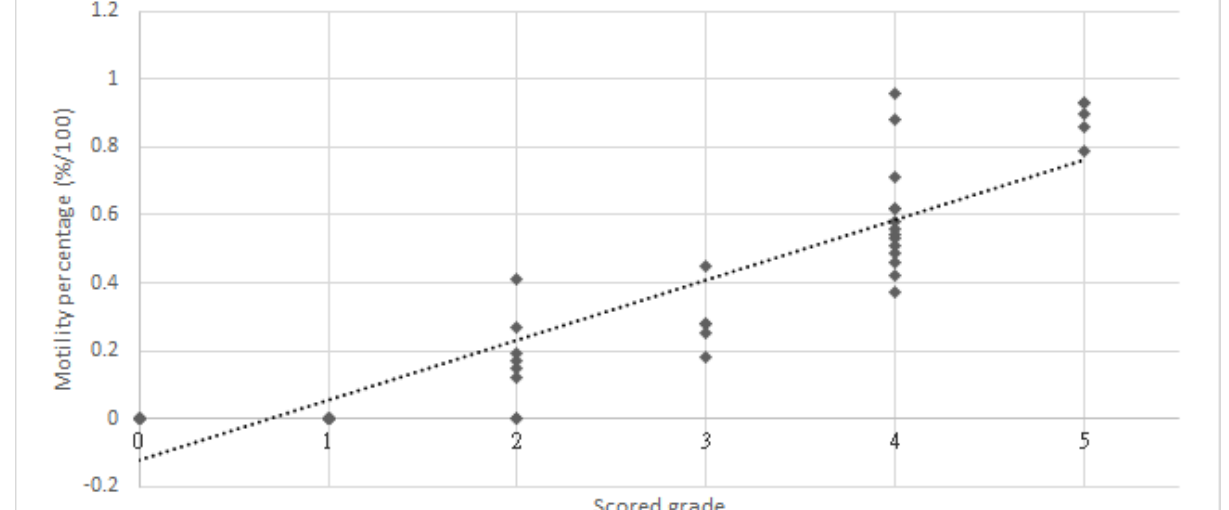
Figure 3. Relationships between Bemaner motility percentage and scored